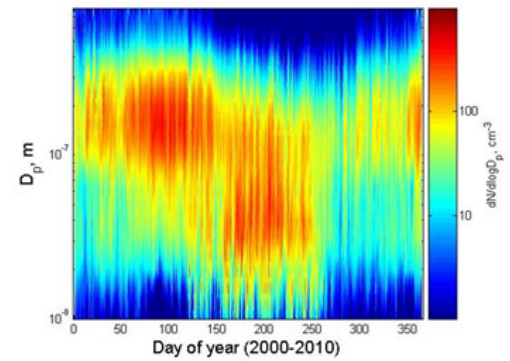
Figure 8. Spectral plot of daily-average aerosol number size distri- butions, March 2000 to December 2010. Units on the x axis are day of the year (Tunved et al., 2013).